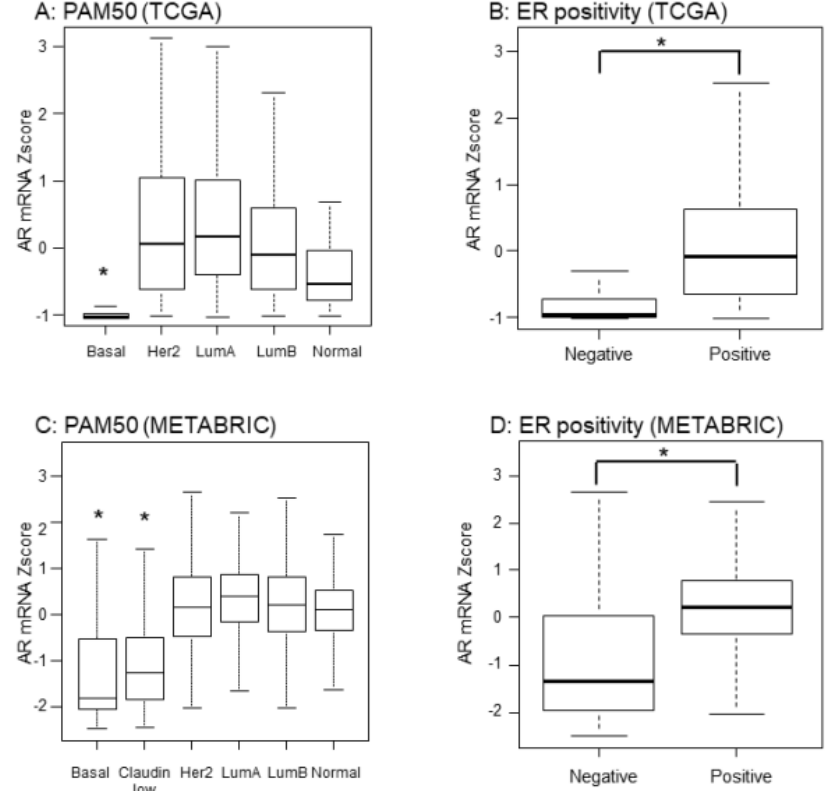
Figure 1. Expression levels of AR mRNA in TCGA and METABRIC cohorts. AR mRNA levels were quantified by mRNA Z-scores of RNA-sequences. Bold lines demonstrate the median and box plot is 95% interval. * p < 0.001. ( A ) PAM50 subtype in TCGA; ( B ) ER positivity defined by IHC in TCGA; ( C ) PAM50 subtype in METABRIC; ( D ) ER positivity defined by IHC in METABRIC.